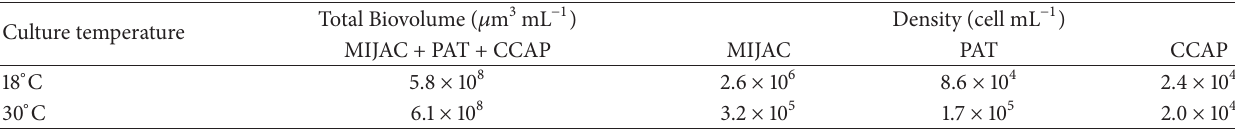
Table 1: Total Biovolume ( 𝜇 m 3 mL −1 ) and Cell density (cell mL −1 ) of each species in mixed-culture among M. aeruginosa (MIJAC), P. agardhii (PAT) and C. meneghiniana (CCAP), after 10 days of growth.